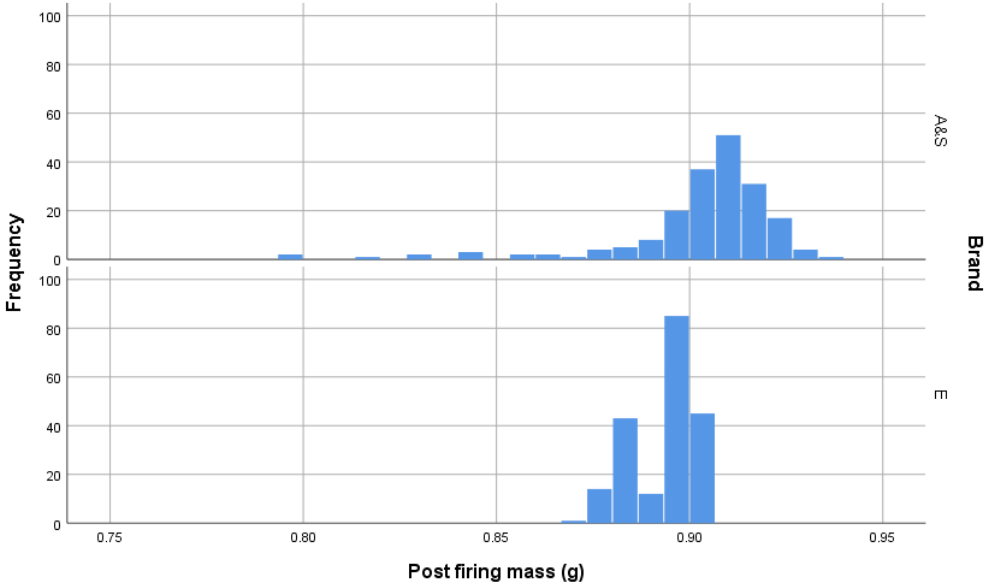
Figure 11. Plot of cartridge weights in grammes post firing.